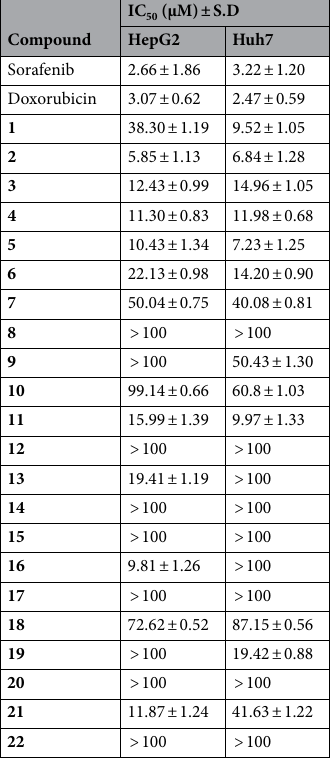
Table 2. Cytotoxicity of isolated compounds against HepG2 and Huh7